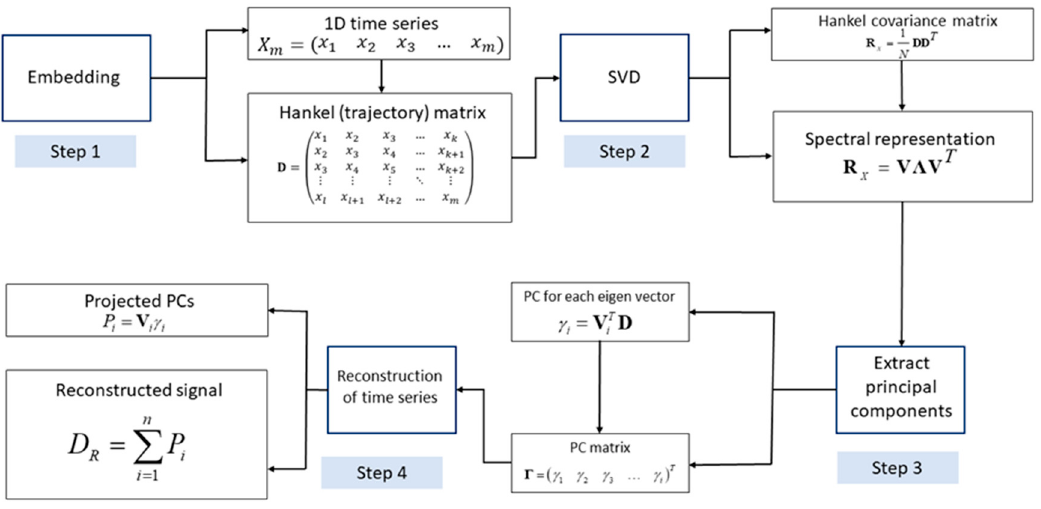
Figure 18. Basic steps of the SSA